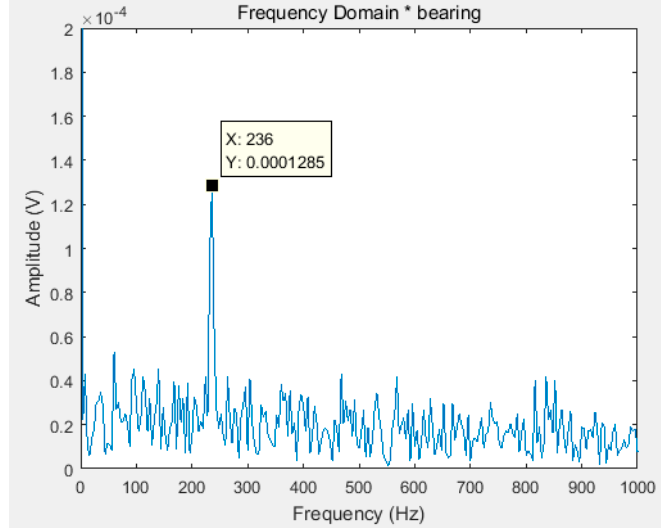
Figure 4. The Fourier transform spectrum of the IMF component with the maximum kurtosis.